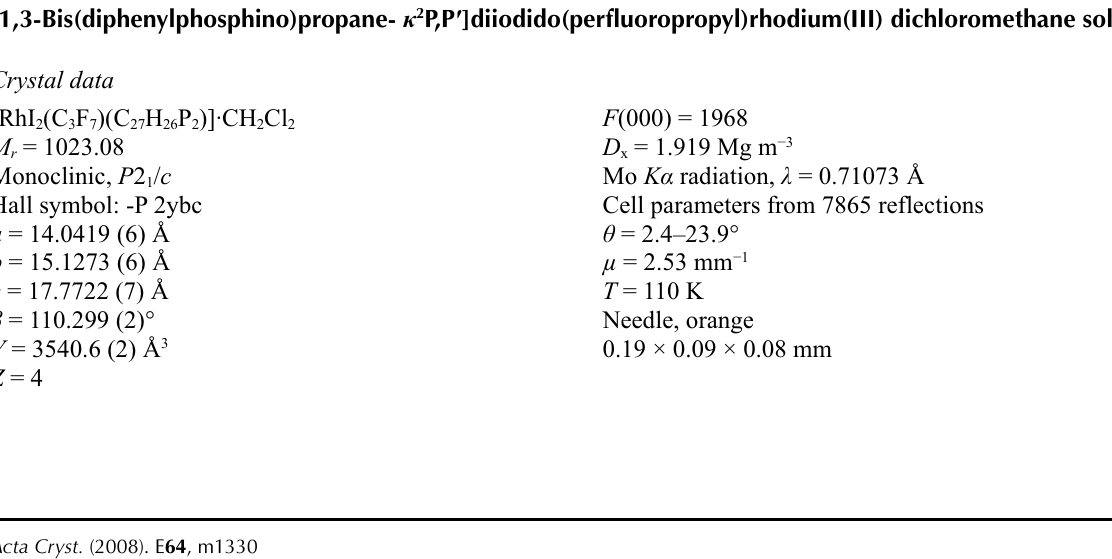
Cl have been omitted for 2 2